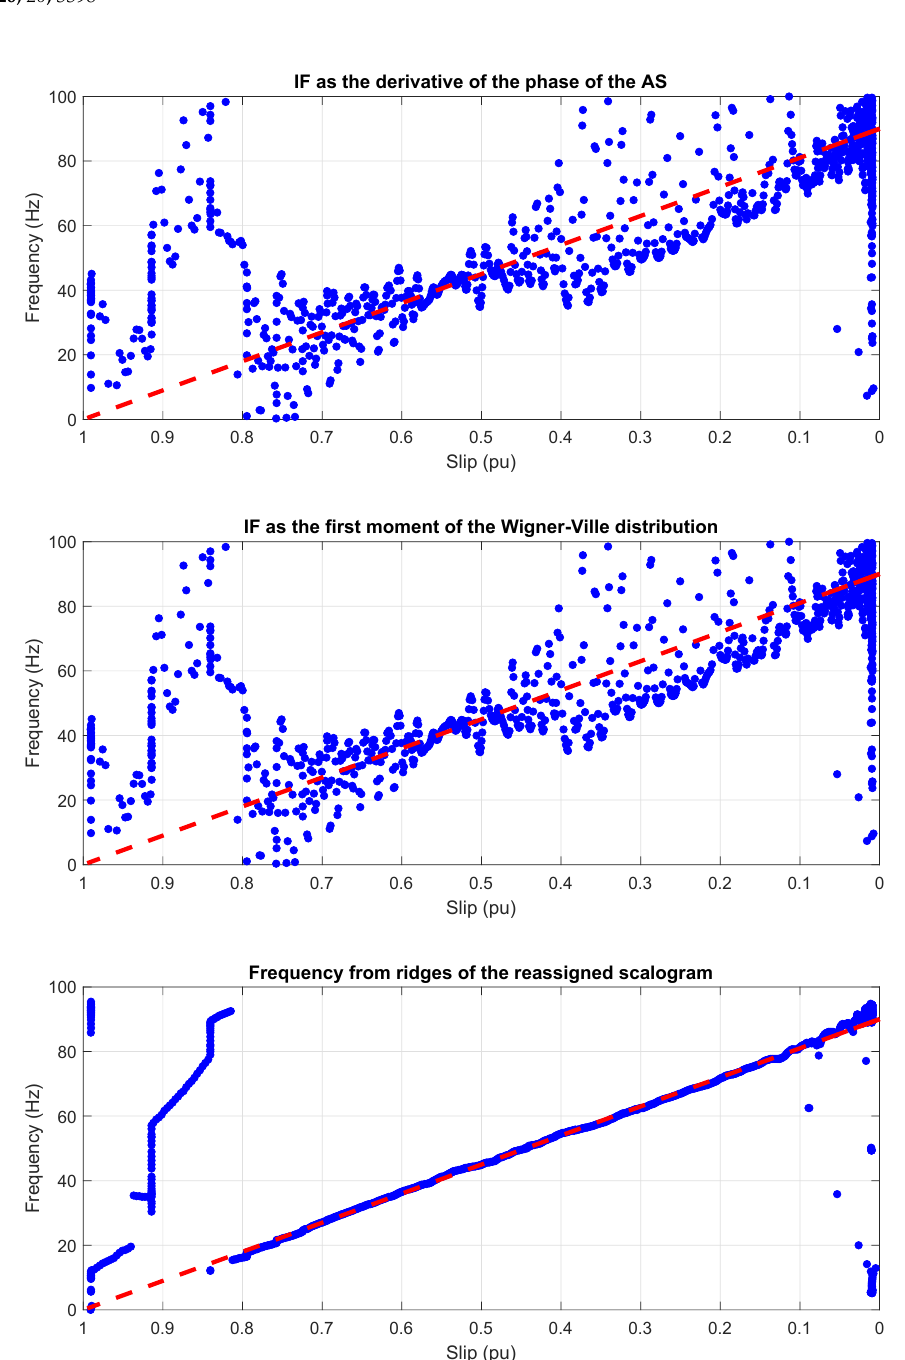
Figure 23. IF versus slip of the main outer race fault components of the start-up current calculated by means of, from top to bottom: Hilbert transform, Wigner Ville distribution, and the scalogram based on the CWT. Dashed, red line: theoretical evolution of the fault harmonic. Blue dots: evolution of the fault harmonic of the experimental